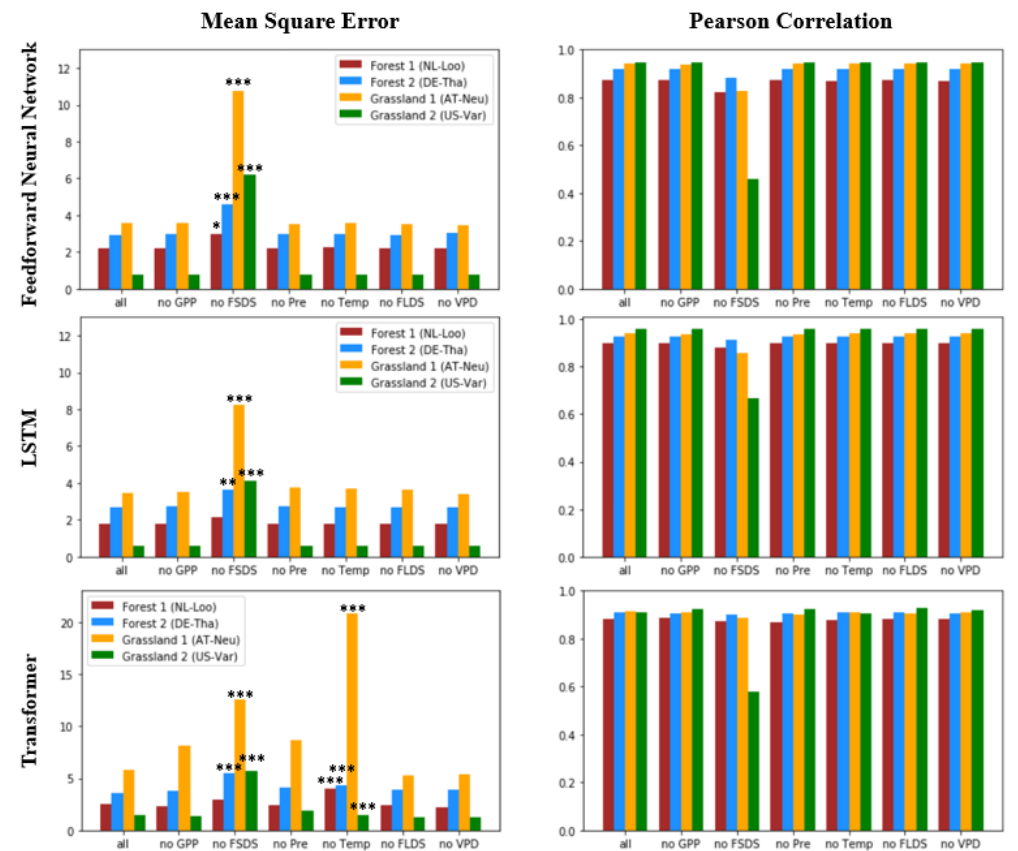
Figure 1. The gross primary product (GPP) prediction performance of (1) the feedforward neural network (FFNN), where only the current climate drivers are utilized; (2) the long short-term memory (LSTM), where current and past climate drivers are taken into account; and (3) the transformer, where current and past climate drivers are comprehensively encoded. A leave-one-out experiment is also conducted for each model, where one of the climate drivers are excluded from the input. Within each neural network candidate, a one-way analysis of variance (ANOVA) followed by a post-hoc Tukey’s honestly significant difference (HSD) test [23] is performed to identify the climate drivers without which the model performance would deteriorate. Asteroids indicate the ones whose square errors significantly deviate from those of the version with all climate drivers provided. One, two and three asteroids respectively corresponds to HSD p-value of less than 0.05, 0.01, and 0.001. GPP: gross primary product; FSDS: shortwave radiation; Pre: precipitation; Temp: temperature; FLDS: longwave radiation; VPD: vapor pressure